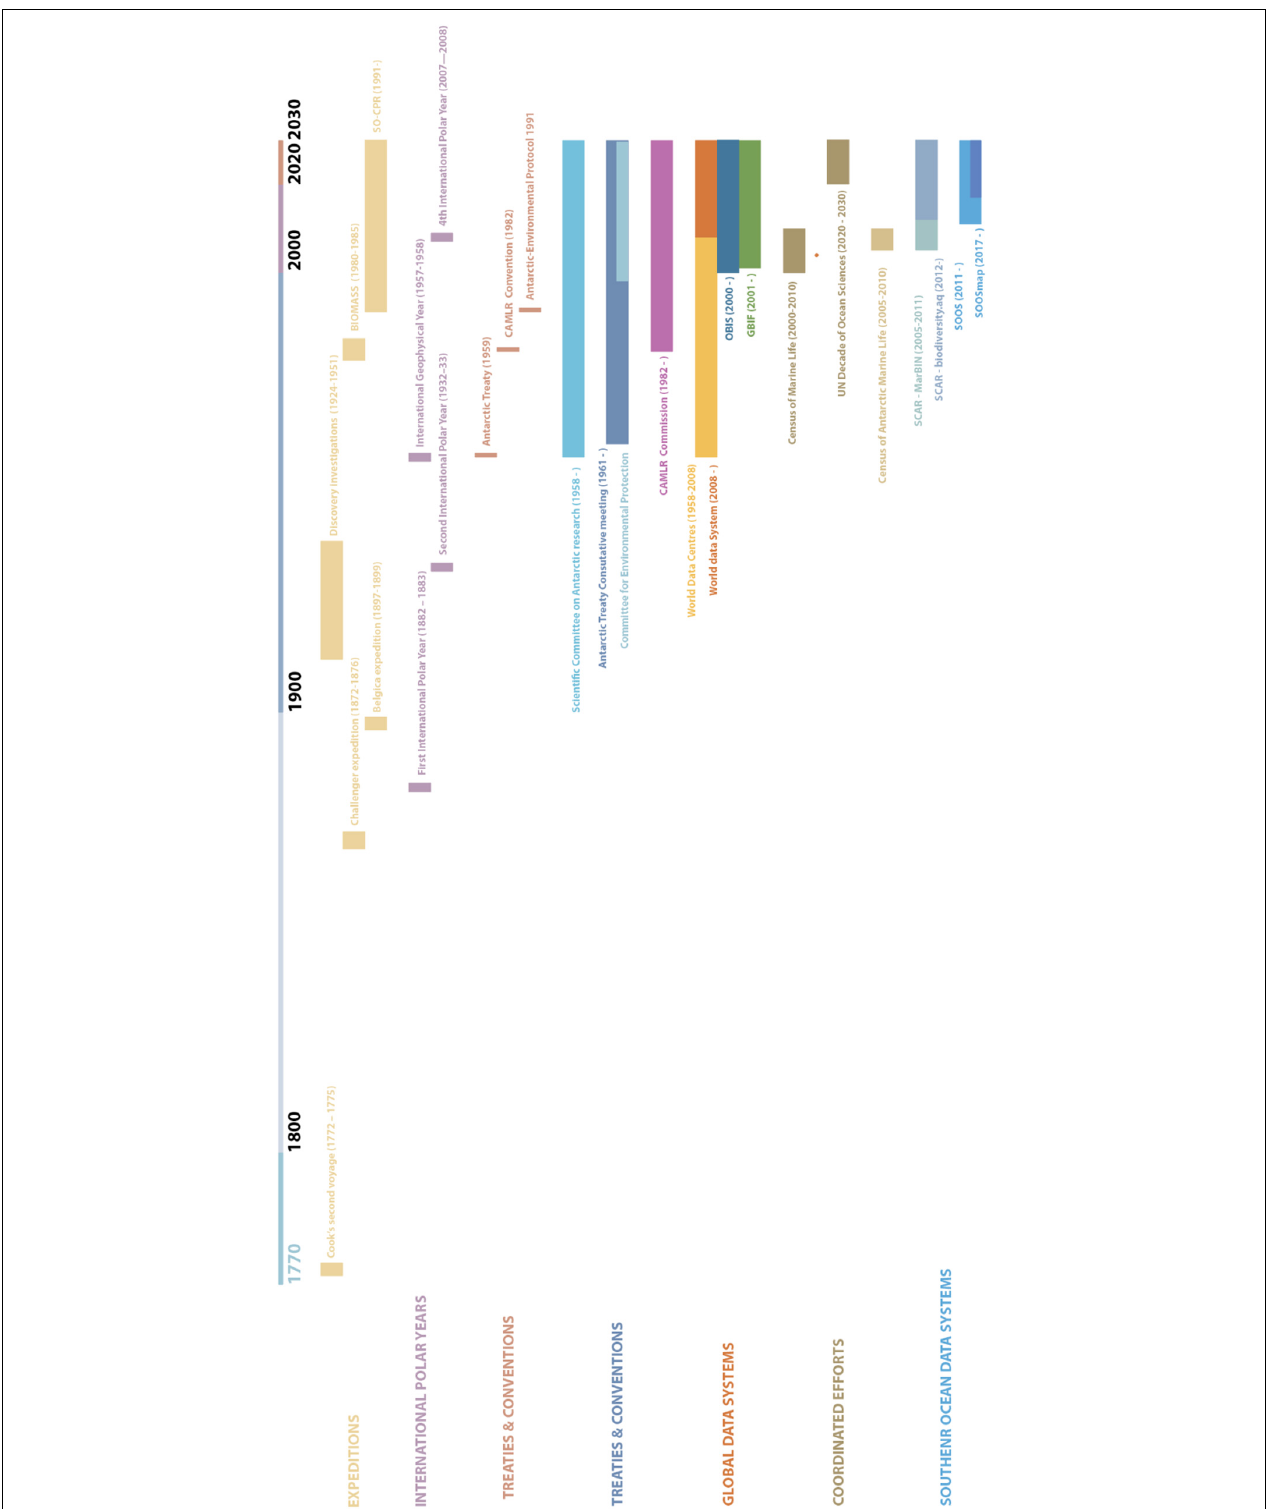
FIGURE 2 | Historical timeline of activities toward an Integrated end to end system in the Southern Ocean. This includes expeditions, International Polar Years, Treaties and conventions, and data systems collaborations within a global context and the context of the Southern Ocean.